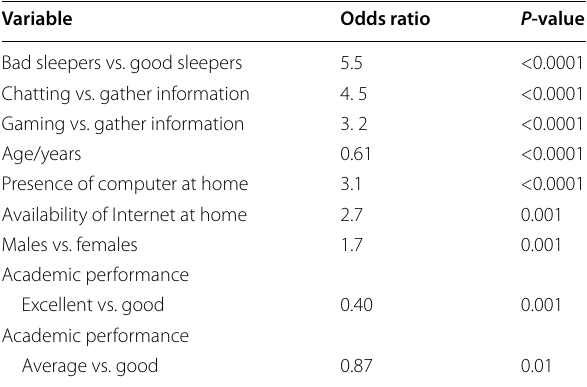
Table 4 Final logistic regression model of factor affecting